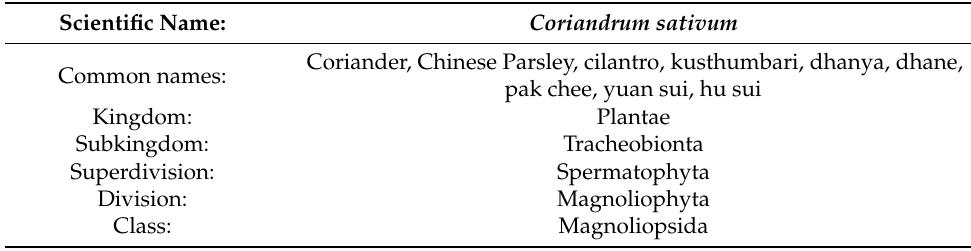
Table 1. The taxonomical classification of C. sativum is as